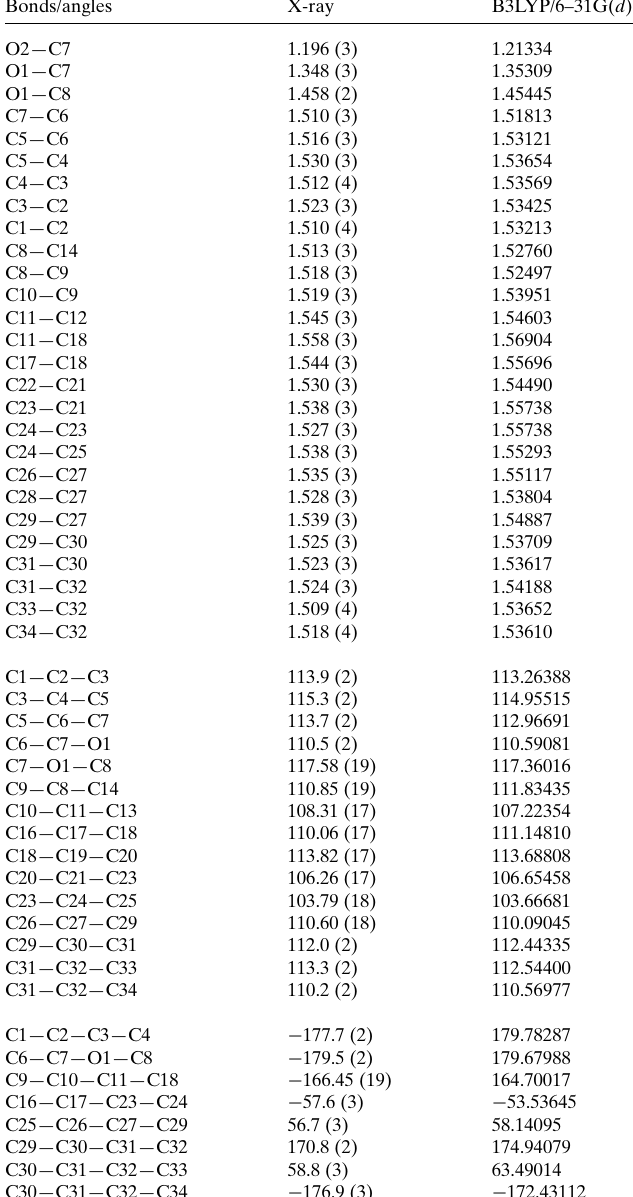
Table 2 Comparison of the selected (X-ray and DFT) geometric data (A˚ , (cid:3) ). Bonds/angles